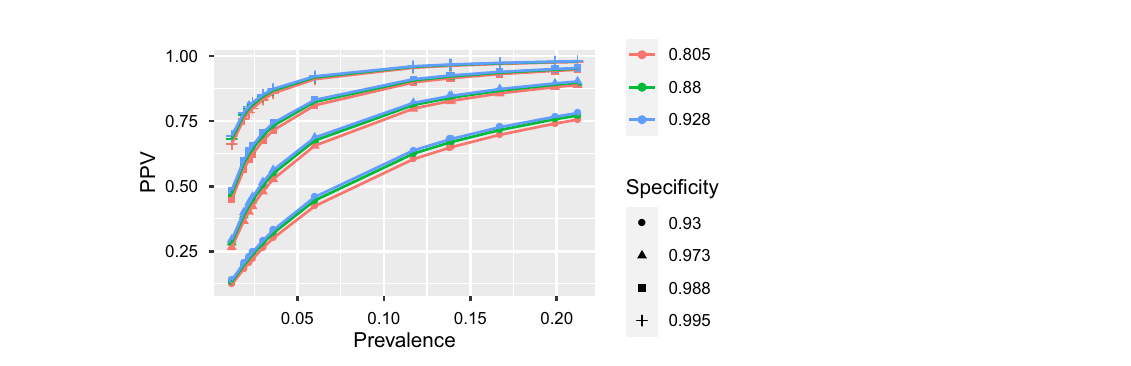
Figure 6. PPV for Antibodies test in New York overall and by region 33,40–42